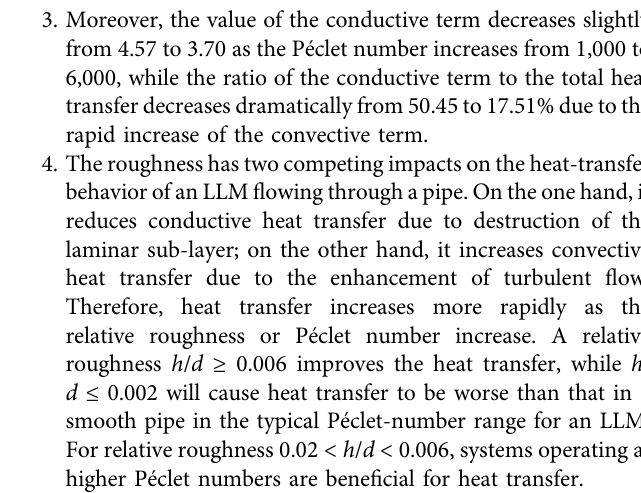
Frontiers in Energy Research |